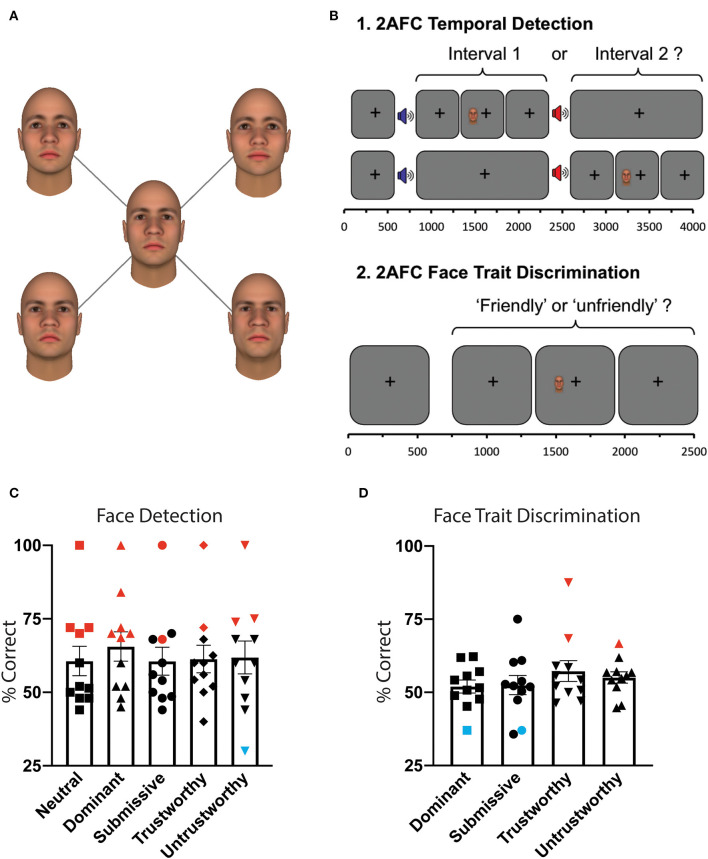
Behavioral paradigm and results. (A) Visual stimuli. All images represent one face identity, showing five levels of facial traits. Dominance and trustworthiness axes were manipulated in three steps (−3, 0, 3) of one standard deviation straddling the neutral. Faces were generated using the Facegen Modeler program (http://facegen.com version 3.1), based upon an extensively validated model (9). (B) Experiment 1: 2AFC temporal detection. Patients fixated on a central cross, with onset of each 1,500 ms interval alerted by a low (interval 1) or high pitch (interval 2) tone. Stimuli were located inside the scotoma (see Figure 1), and could appear in either interval at random, for a period of 500 ms. At the end of the trial, participants had to decide in which interval it appeared. Stimuli consisted of a face of 5.25 or 7.25° height, exhibiting either a dominant, submissive, trustworthy, untrustworthy, or neutral expression, at random. Experiment 2: 2AFC face trait discrimination. Throughout each trial of 2,500 ms duration, participants were required to fixate on a central black cross. During this time, the stimulus appeared inside the scotoma for 500 ms with jittered onset. At the end of the trial, patients had to indicate whether the face had been “friendly” or “unfriendly.” If they saw nothing, they were instructed to guess. (C) Mean behavioral performance for all participants who completed this task (n = 11) ± standard error of the mean (SEM) for 2AFC temporal detection, as a function of face trait. Statistically significant performance above chance was shown with red symbols, below chance in blue, all others in black. (D) Mean behavioral performance for all participants who completed this task (n = 11) ± SEM for 2AFC face trait discrimination.